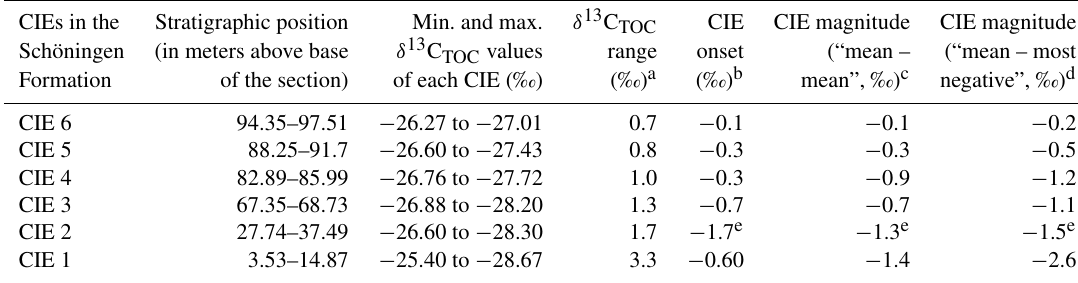
Table 2. CIEs in the δ 13 C TOC dataset of the Schöningen Formation (Main Seam–Seam 6, western syncline). CIEs in the Stratigraphic position Min. and max. δ 13 C TOC CIE CIE magnitude CIE magnitude Schöningen (in meters above base δ 13 C TOC values range onset (“mean – (“mean – most Formation of the section) of each CIE (‰) (‰) a (‰) b mean”, ‰) c negative”, ‰) d CIE 6 94.35–97.51 − 26.27 to − 27.01 0.7 − 0.1 − 0.1 − 0.2 CIE 5 88.25–91.7 − 26.60 to − 27.43 0.8 − 0.3 − 0.5 CIE 4 82.89–85.99 − 26.76 to − 27.72 CIE 3 67.35–68.73 − 26.88 to − 28.20